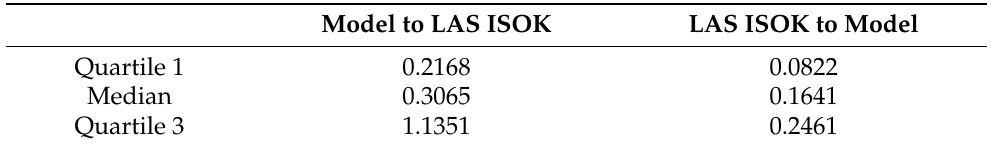
Table 2. Comparison of the fit of the reconstructed model to the LAS ISOK point cloud and the LAS ISOK point cloud to the reconstructed model.